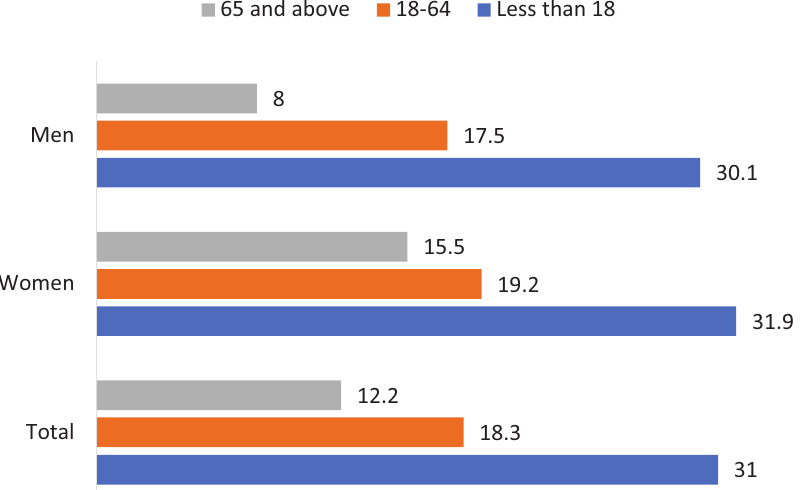
Figure 1. Risk of poverty rate (%) by age and sex (Catalonia 2019). Source: Own elaboration with data from IDESCAT (2019). countries (UNICEF, 2014). Finally, changes in the social structure, especially in family models and their functions (Carrasco et al., 2005; Gómez‐Granell, 2004) are under‐ mining the pillar of a family‐centred welfare state (Ayllón, 2017; Cantó,